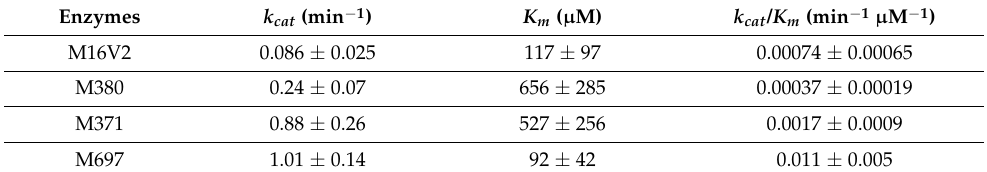
Table 1. Kinetic parameters of monacolin J hydroxylation using M380, M371, M697, and CYP16V2. Enzymes